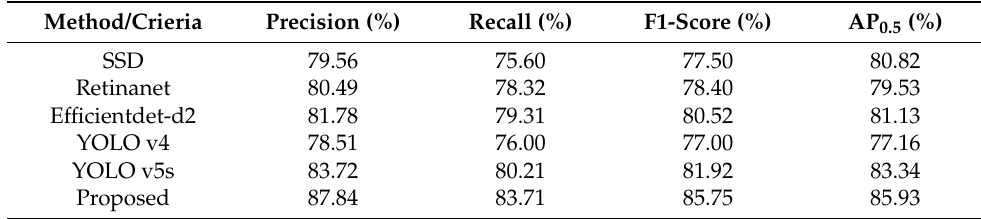
Table 3. Results on the small and thin smoke dataset in the early fire stage.